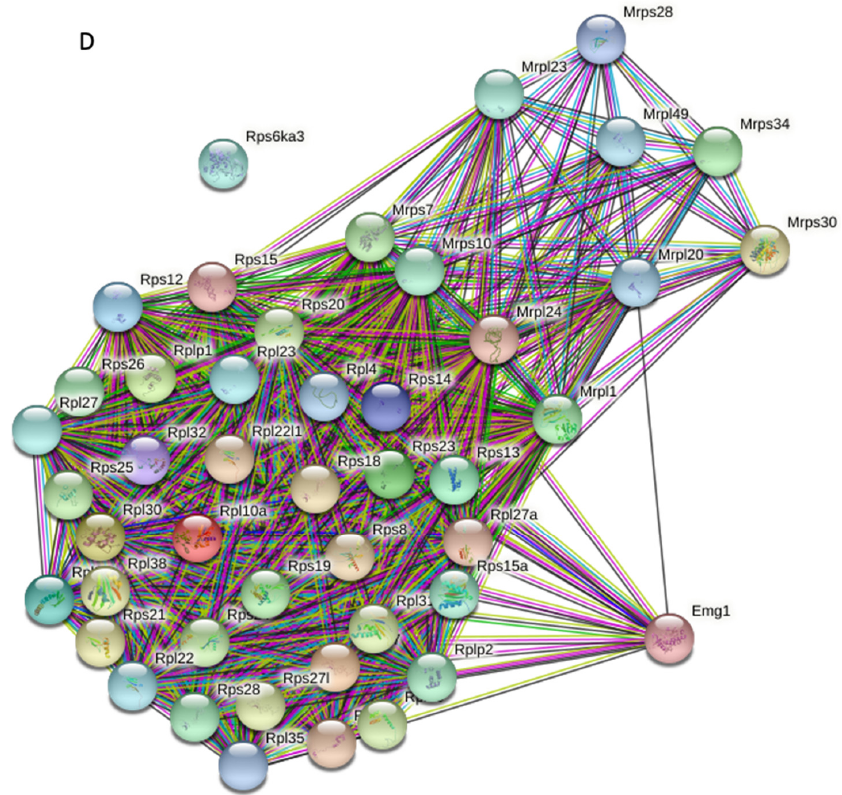
Figure 6. ( A ): The mass spectrometric based label free quantification permitted the identification of the ribosomal proteins found to be down-regulated in Carl − / − embryonic kidney. ( B , C ): Volcano plots illustrating the ribosomal proteins found to be up-regulated in Calr +/+ compared to Calr − / − ( B ) and in Calr +/ − compared to Carl − / − ( C ). Remarkably, several mitochondrial ribosomal proteins were up-regulated in Calr − / − . ( D ): Networking analysis of ribosomal protein found to be regulated in the Calr − / − compared to Calr +/+ and Calr +/ − using the protein networks software String (https://string-db.org, accessed on 24 May 2021). A strong interaction node was established between the proteins supporting common functional processes.